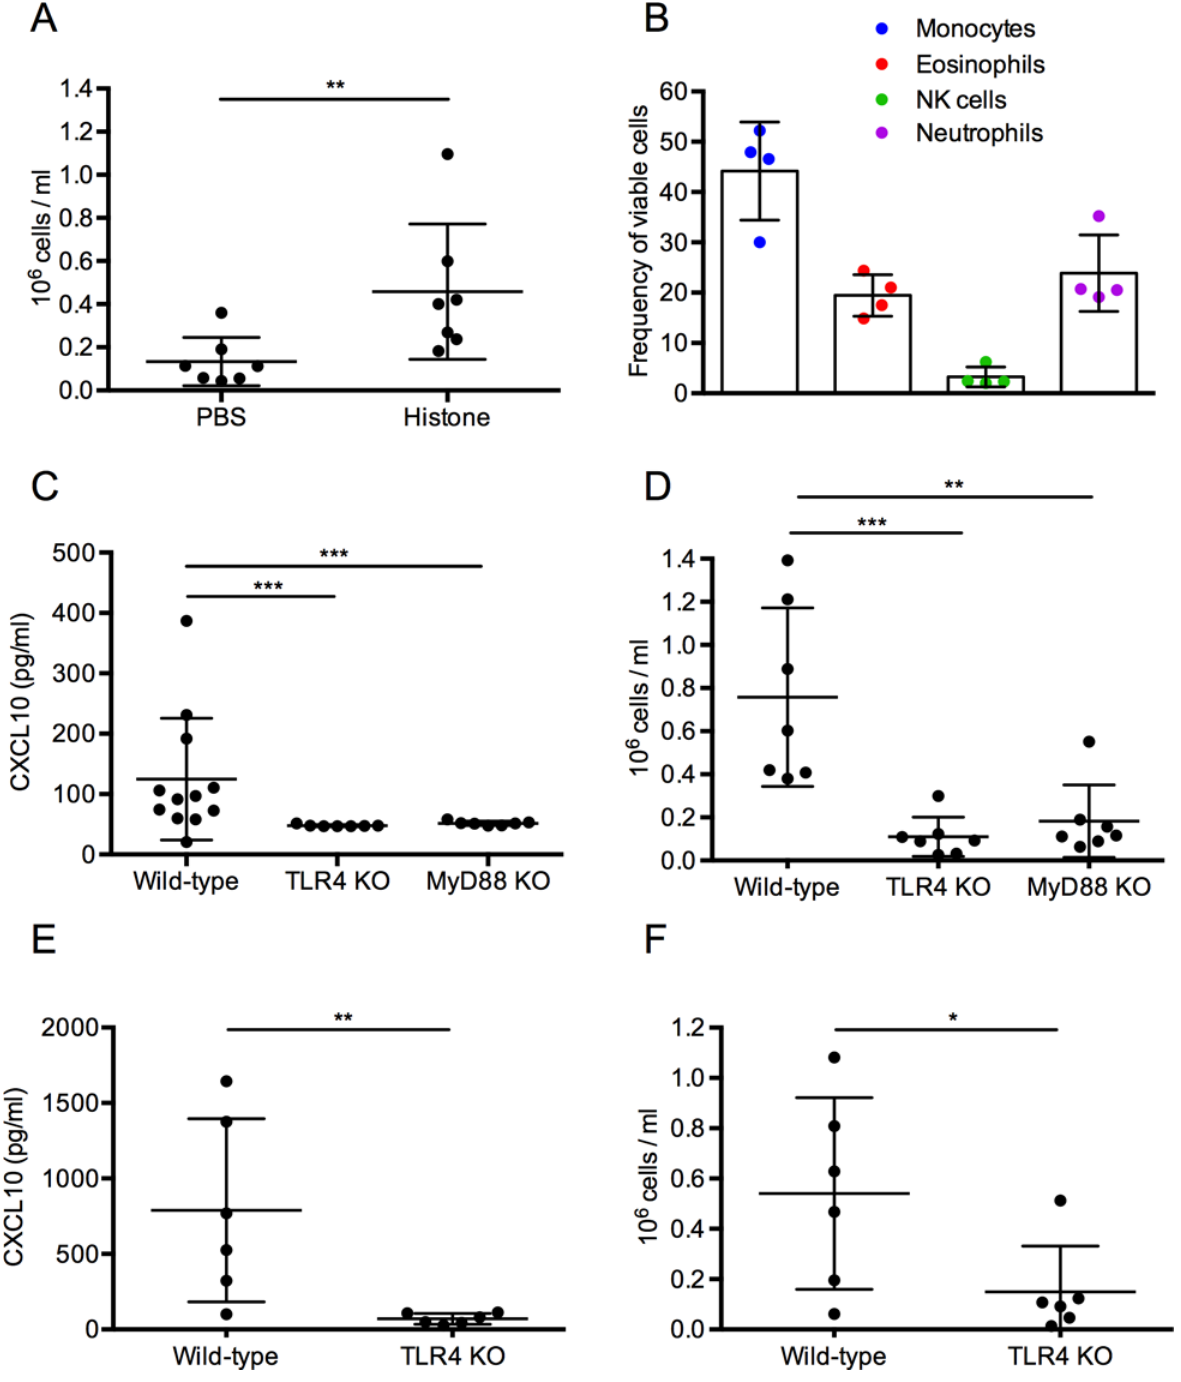
Fig 8. Subcutaneous injection of CTHs induces leukocyte recruitment and local production of CXCL10. (A) Balb/c mice (CTHs (n = 7) and PBS (n = 7)) were challenged with 100 μ l of a 10 μ g/ml CTHs solution and the number of leukocytes that infiltrated the air pouch were measured. (B) Identification of cellular subsets recruited into the mice air pouch was done as described in Material and Methods. Monocytes (CD11b + Ly6C + CD64 + ), neutrophils (CD11b + Ly6G + ), eosinophils (CD11b - CD64 - Ly6C int SSC-A high ) and NK cells (CD11b - Ly6G - NK1.1 + ) were identified after gating on PI - CD3 - B220 - events. (C) Mice received an injection with 100 μ l of a 10 μ g/ml CTH solution and the air pouch supernatants from C57BL/6 wild-type (n = 12), TLR4 KO (n = 7), and MyD88 KO (n = 7) mice were used to measure the local levels of CXCL10. (D) Mice received an injection with 100 μ l of a 10 μ g/ml CTH solution and the number of leukocytes that infiltrated the air pouch, are depicted for wild-type (n = 7), TLR4 KO (n = 7), and MyD88 KO (n = 7) and mice. (E) Mice received an injection with 100 μ l of a 100 μ M IRR20 solution and the air pouch supernatants from wild-type (n = 6) and TLR4 knockout (n = 6) mice were used to measure